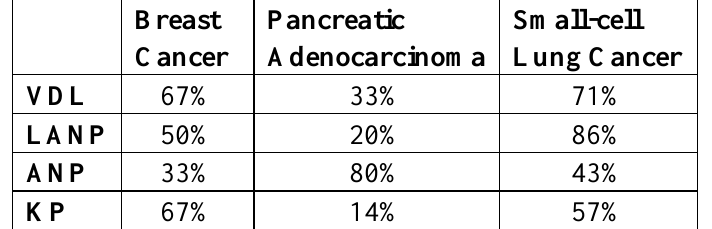
Table 1. Cardiac Hormones Ability to Eliminate Human Cancer Growing in Athymic Mice.